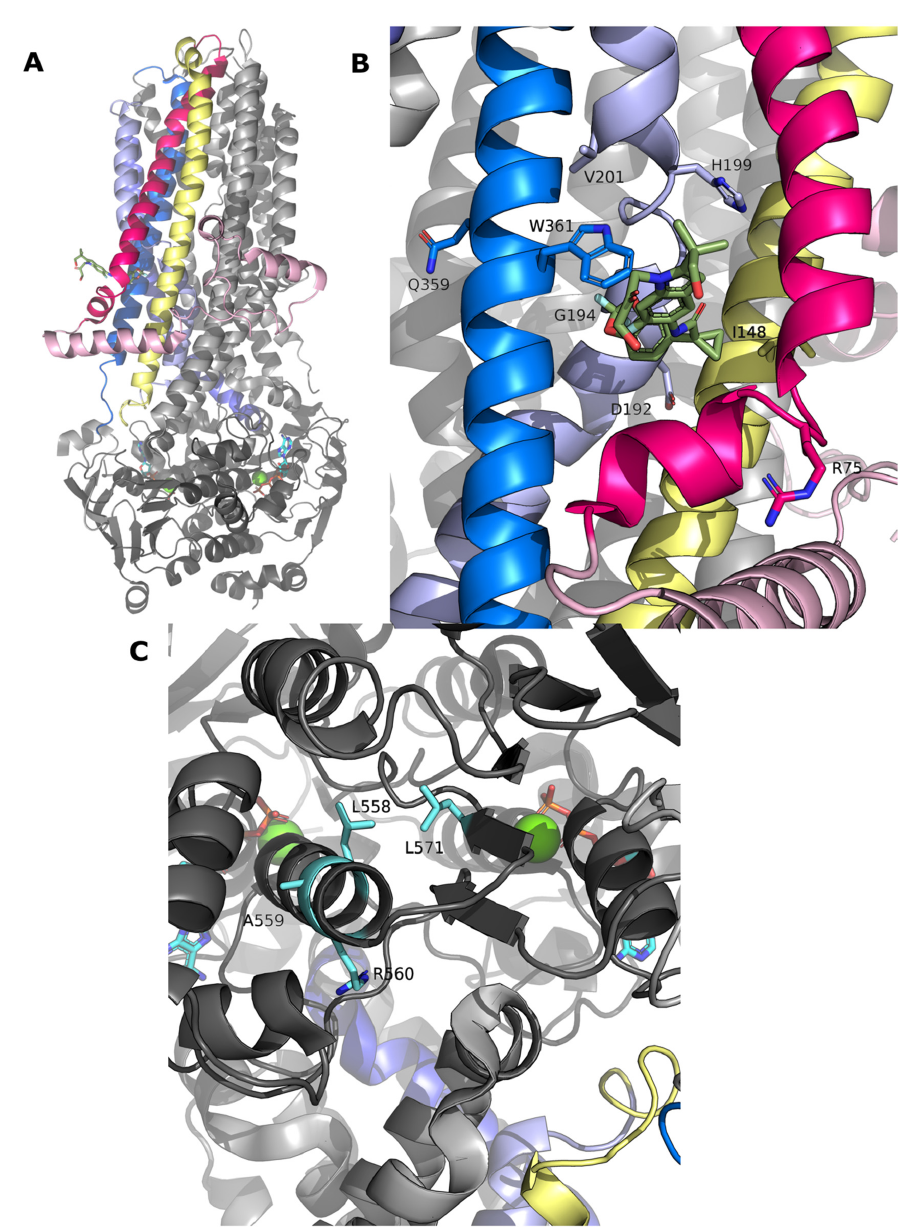
Figure 9. ( A ) Overall CFTR structure in the presence of VX-661 (PDB:7SV7), colored in green sticks. ( B ) Zoom of the binding region of VX-661 at CFTR structure. Residues analyzed in this work are colored and labeled in sticks. ( C ) Zoom of the NBD1 region, where some residues analyzed are located. Side chains of the residues are labeled and represented as cyan sticks. We demonstrate that H139R abolishes CFTR processing, but treatment with VX-661, VX-445, and particularly the combination of both, leads to a significant increase in band C. Although this mutation is located far from the reported binding site of VX-661 (at the TM2 of TMD1—Figure 9B), it is found to be in close proximity with the binding site reported for VX-445 [33].The substitution of a polar amino acid, by a large and positively